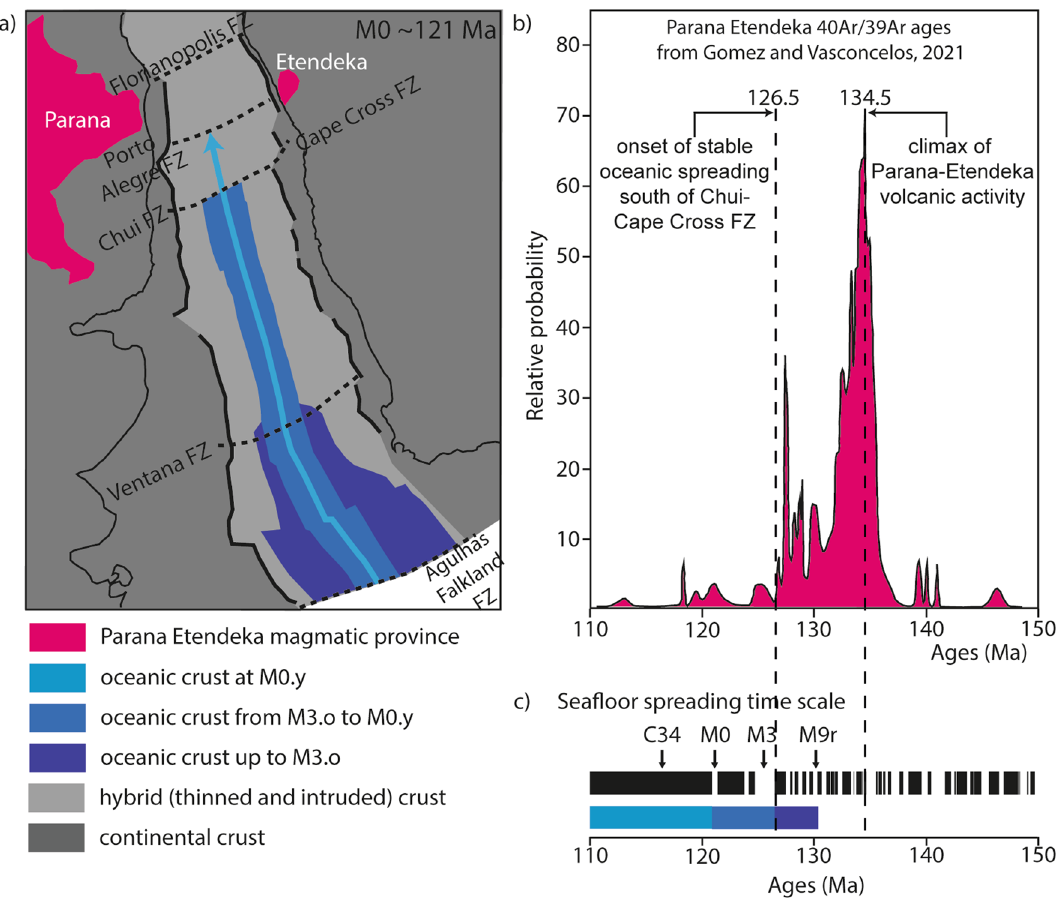
Figure 8. Onset of steady-state seafloor spreading in the South Atlantic Ocean relative to the Paraná–Etendeka volcanic event. ( a ) map reconstructed at M0, ( b ) probability for radiometric dated Paraná and Etendeka volcanic events between 110 and 150 Ma 42 , ( c ) geomagnetic time scale between 110 and 150 Ma and corresponding periods of seafloor spreading shown in